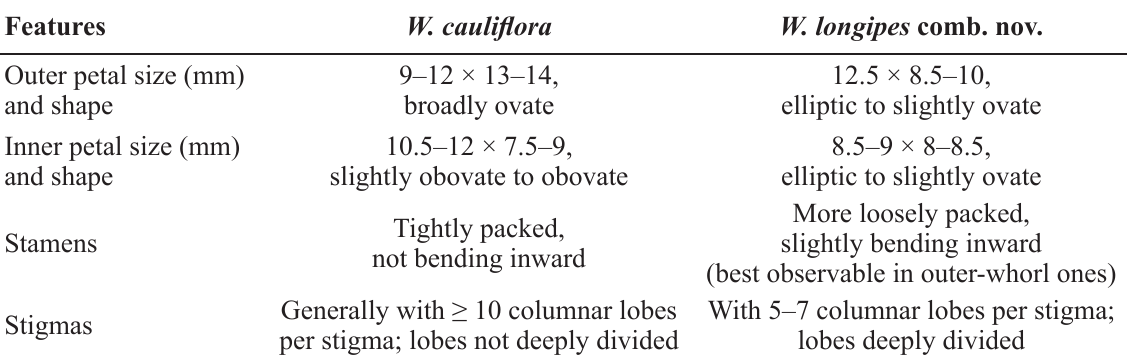
Table 1. Principal morphological differences between Winitia cauliflora (Scheff.) Chaowasku and Winitia longipes (Craib) Chaowasku & Aongyong comb.